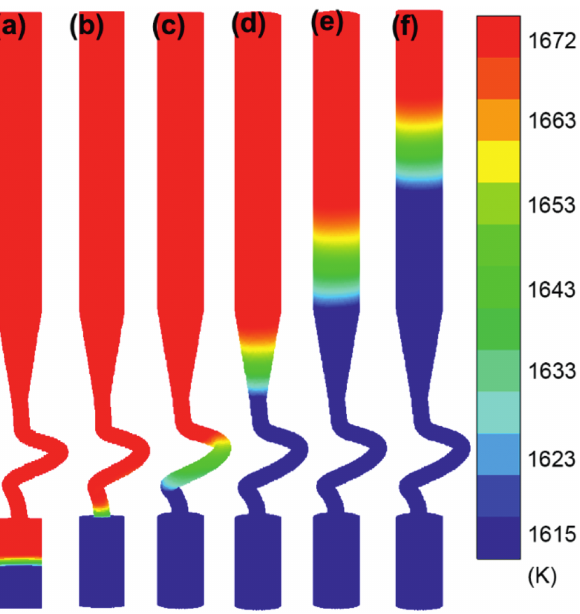
Figure 3: Mushy zone distribution of Ni-based casting samples for the HRS process: (a) t = 30 s, f s = 10%; (b) t = 78 s, f s = 20%; (c) t = 157 s, f s = 22%; (d) t = 1,337 s, f s = 27%; (e) t = 1,755 s, f t = 2,125 s, f s = 45%; (f) s = 70%.